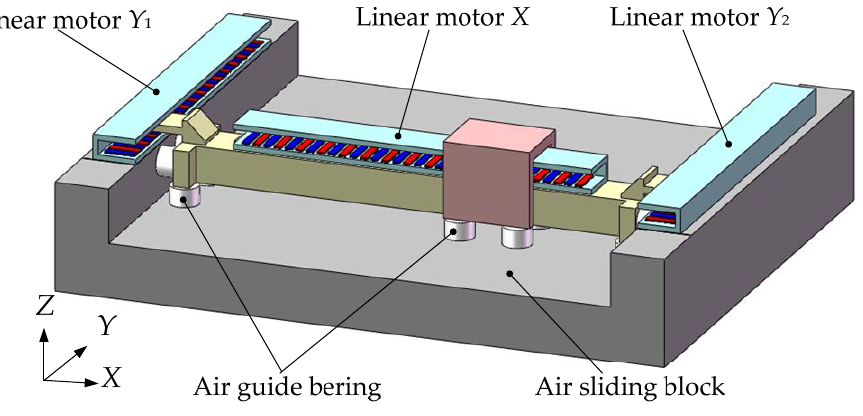
Figure 1. Structure diagram of the H ‐ type platform.